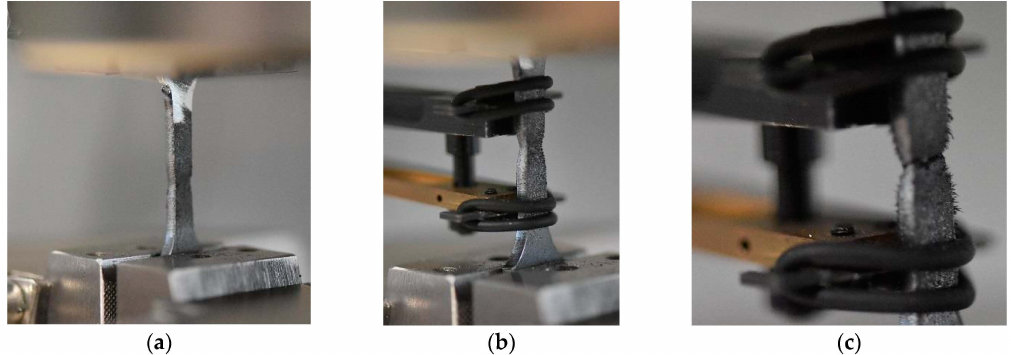
Figure 8. S700MC steel at final stage of tensile tests conducted at the following values of velocity of loading